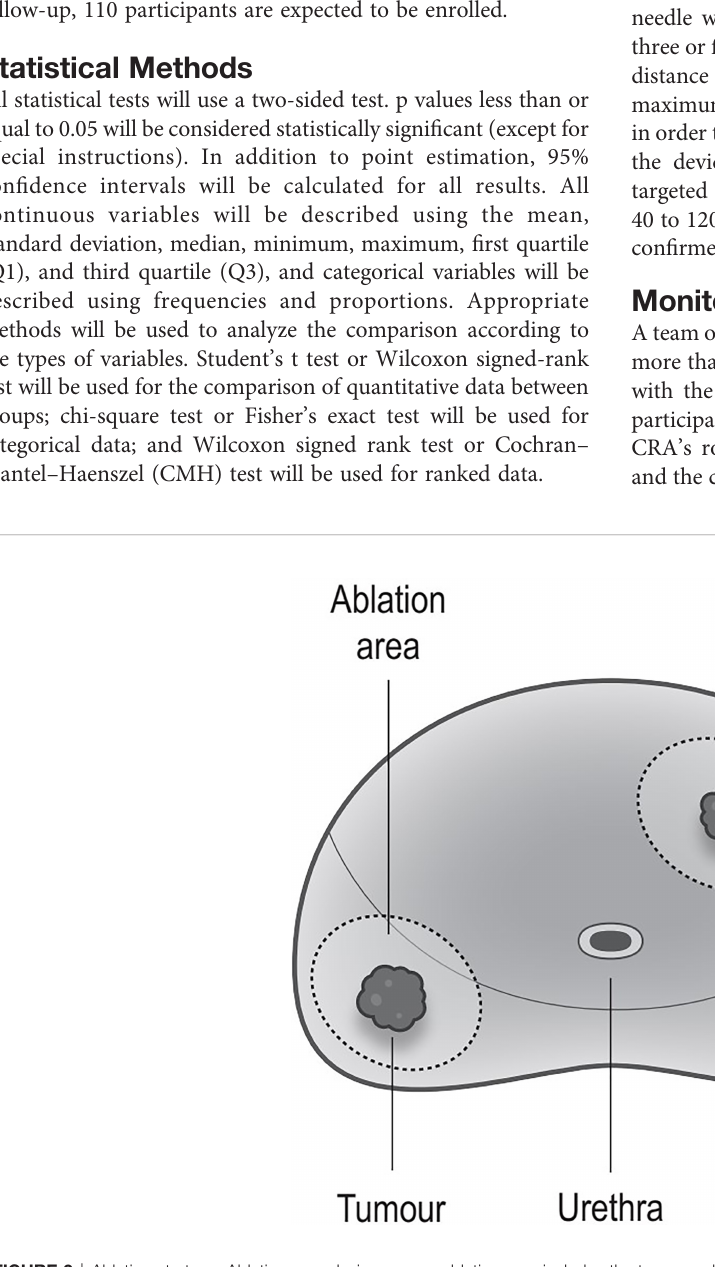
FIGURE 2 | Ablation strategy. Ablation every lesions; every ablation area includes the tumor and some surrounding benign tissues (the safety margin is >1